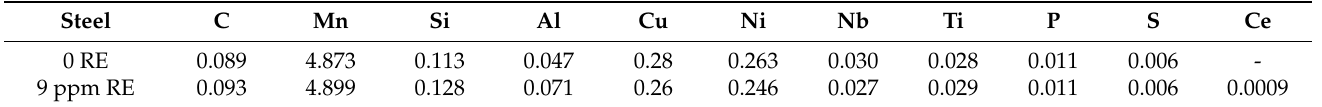
Table 1. Chemical composition of test steel